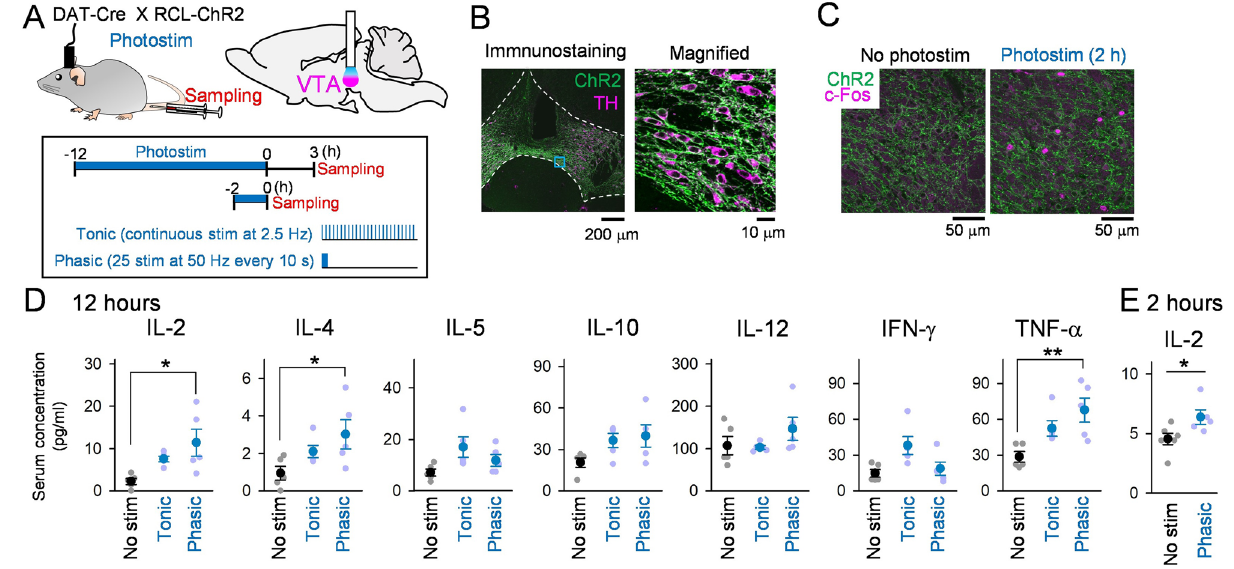
Figure 1. Photostimulation of the VTA DA neurons increases serum cytokine levels. ( A ) In DAT-Cre × RCL- ChR2-eYFP mice, photostimulation was applied to the right VTA through an optic fiber for 12 h or 2 h, and a blood sample was collected from the tail vein after 3 h or immediately, respectively. The bottom inset shows the experimental paradigm. ( B ) (Left) A coronal section showing neurons in the VTA immunostained with ChR2-eYFP (green) and TH (magenta) antibodies. The cyan region is magnified in the right panel. ( C ) Immunostaining of VTA neurons with ChR2-eYFP (green) and c-Fos (magenta) antibodies after 2 h of VTA photostimulation. ( D ) Serum concentrations of seven cytokines tested after 12-h VTA photostimulation ( n = 5 mice each). Each thin dot represents one mouse. * P < 0.05, ** P < 0.01. ( E ) Same as D but serum concentration of IL-2 was tested after 2-h VTA phasic photostimulation ( n = 6 and 5 mice). * P <